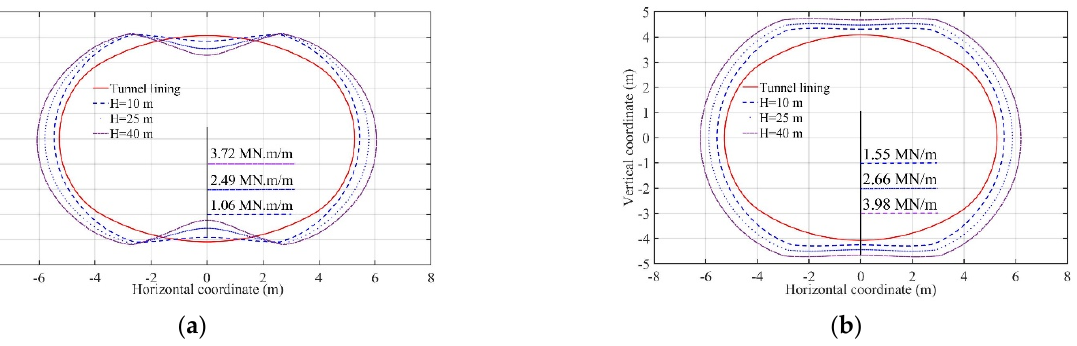
Figure 5. Distributions of internal forces of lining under different H. ( a ) Bending moments M ; ( b ) Normal forces N .